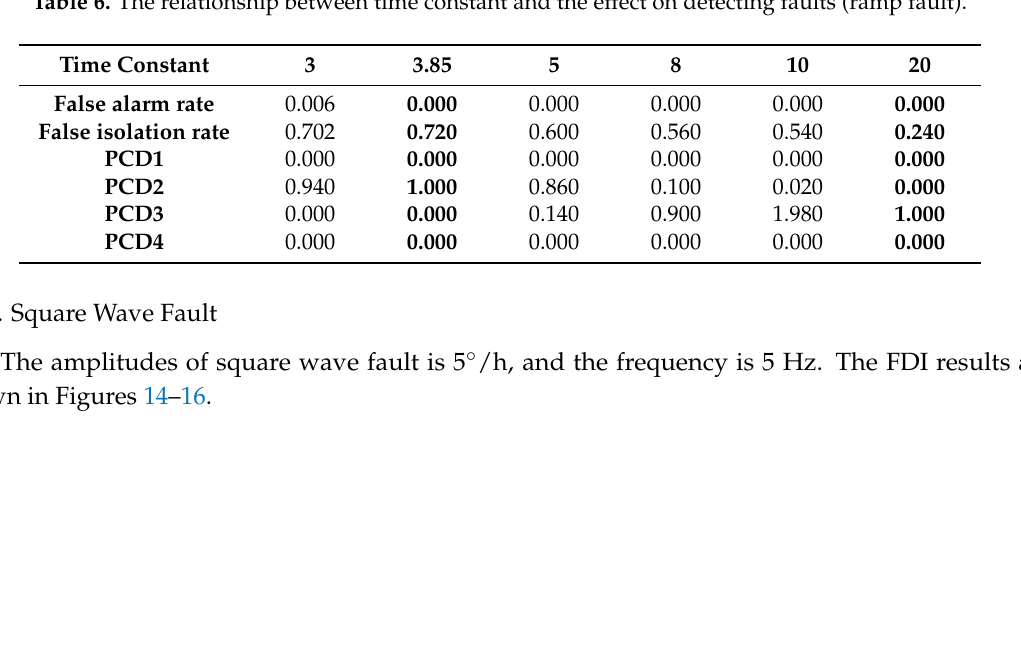
Table 6. The relationship between time constant and the effect on detecting faults (ramp